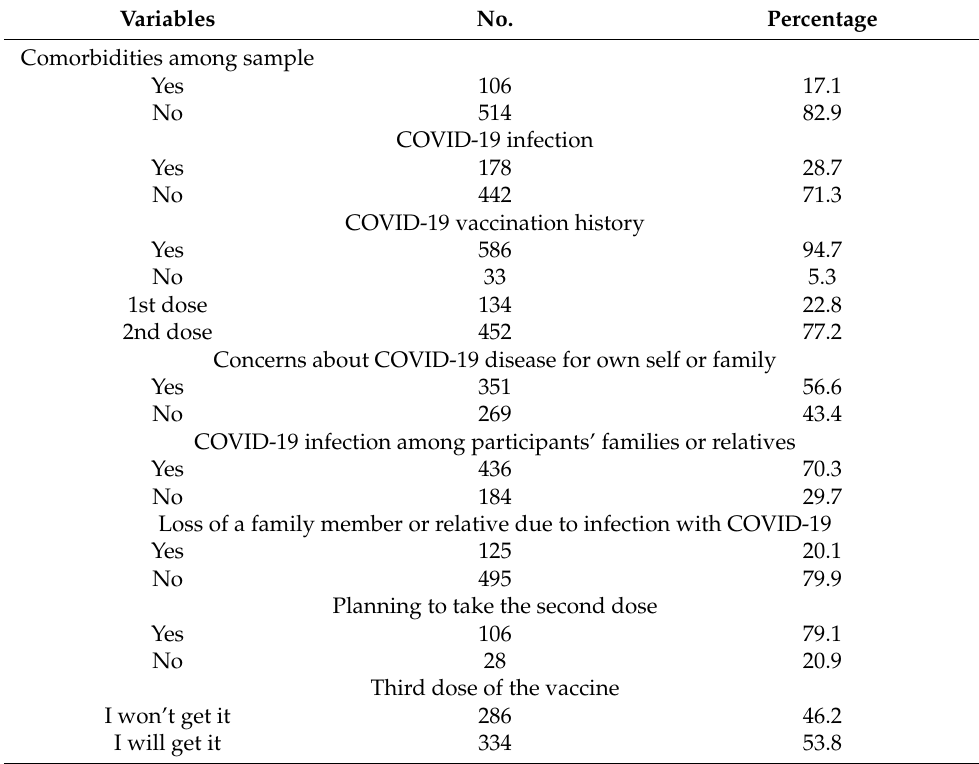
Table 2. COVID-19 infection and vaccination data among study participants.